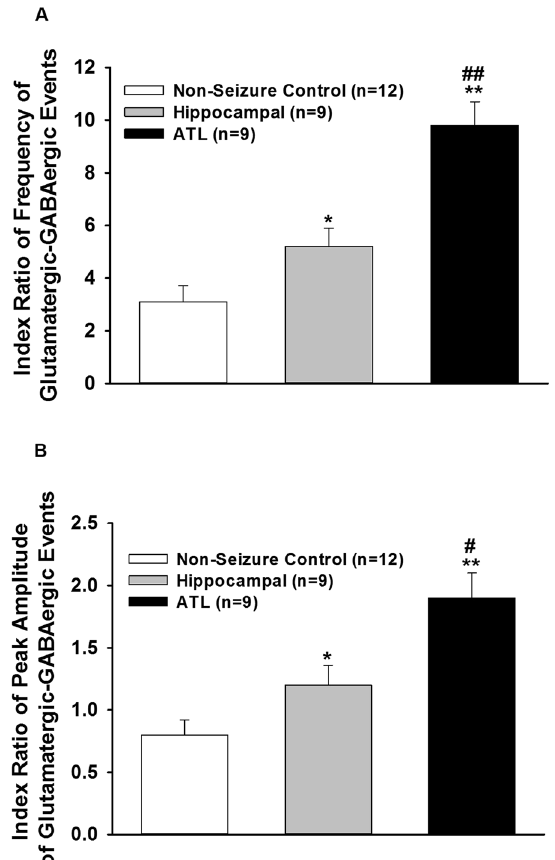
Figure 7. Index ratio of glutamatergic-GABAergic events. ( A ) Index ratio for frequency was obtained by dividing the average frequency of glutamatergic events by that of GABAergic events in a subset of pyramidal neurons where the spontaneous EPSCs and IPSCs could be recorded in the same cell of non-seizure control and the hippocampal and ATL samples of patients with HS. In comparison to the ATL samples the index ratio of frequency was lower in the hippocampal samples. ( B ) Index ratio for peak amplitude was obtained by dividing the mean peak amplitude of glutamatergic events by that of GABAergic events in a subset of pyramidal neurons where the spontaneous EPSCs and IPSCs could be recorded in the same neuron of non-seizure control and the hippocampal and ATL samples of patients with HS. The index ratio of peak amplitude in the hippocampal samples was lower compared to the ATL samples. Graph and error bars represent mean and S.E.M., respectively, of data obtained from twelve non-seizure control samples from twelve patients, and nine hippocampal and nine ATL samples obtained from nine patients with HS. * p < 0.05; ** p < 0.001 compared to non-seizure control according to one-way ANOVA followed by Dunnett post-hoc test. # p < 0.05; ## p < 0.01 according to one-way ANOVA followed by Tukey post hoc